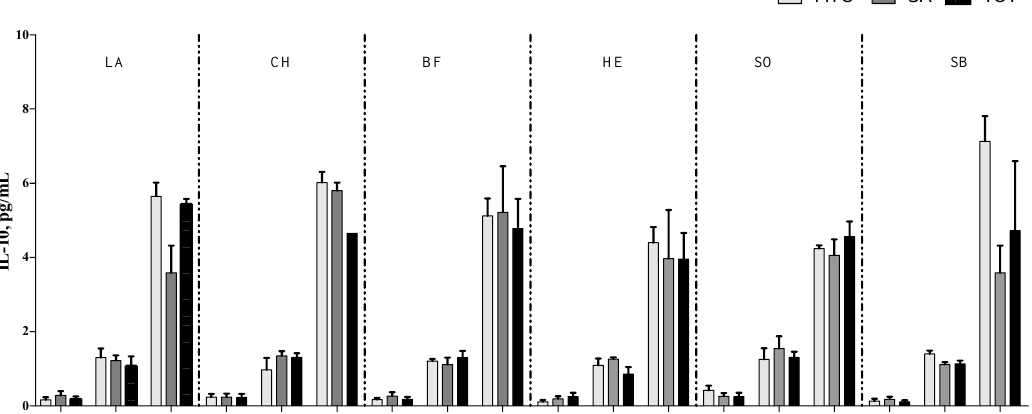
Figure 4. IL-10 secretion (means ± SE; pg/mL) in peripheral blood mononuclear cell supernatants of infants with generalized epilepsy treated in vitro with myofibrillar (MYO, light-grey bar), sarco- plasmic (SA, grey bar), and total protein (TOT, black bar) fractions from beef (BF), lamb (LA), chicken (CH), sole (SO), European hake (EH), and sea bass (SB) sources. LL-EC = group of children with epilepsy with similar levels of cytokines to those of control children; ML-EC = group of children with epilepsy with cytokine levels at least 2-fold higher (medium levels) than those of control chil- dren; HL-EC = group of children with epilepsy with cytokine levels at least 8-fold higher (high lev- els) than those of control children.